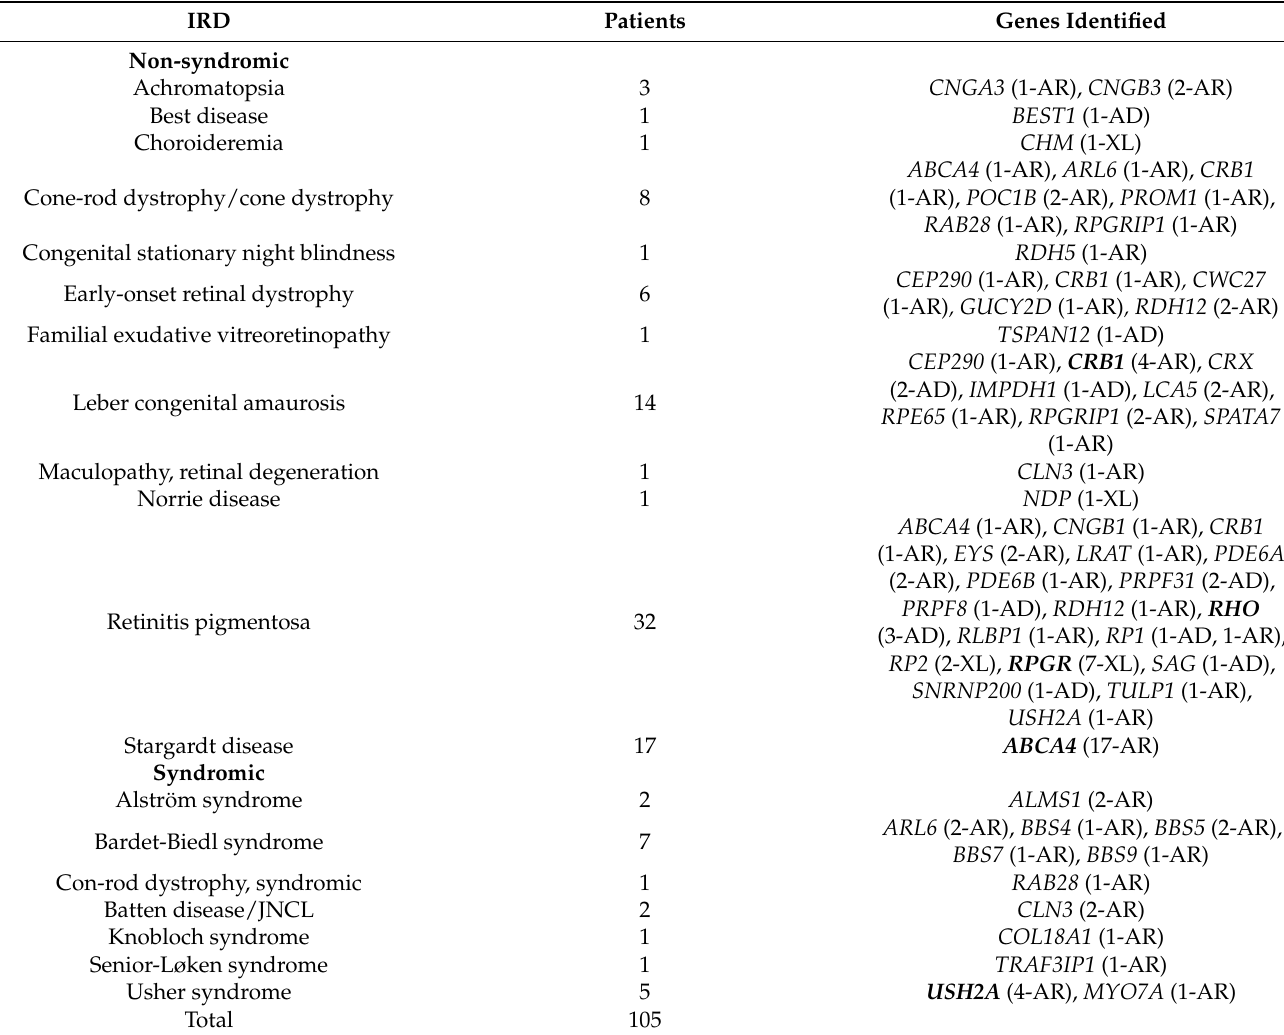
Table 2. Number of patients with positive genetic testing per